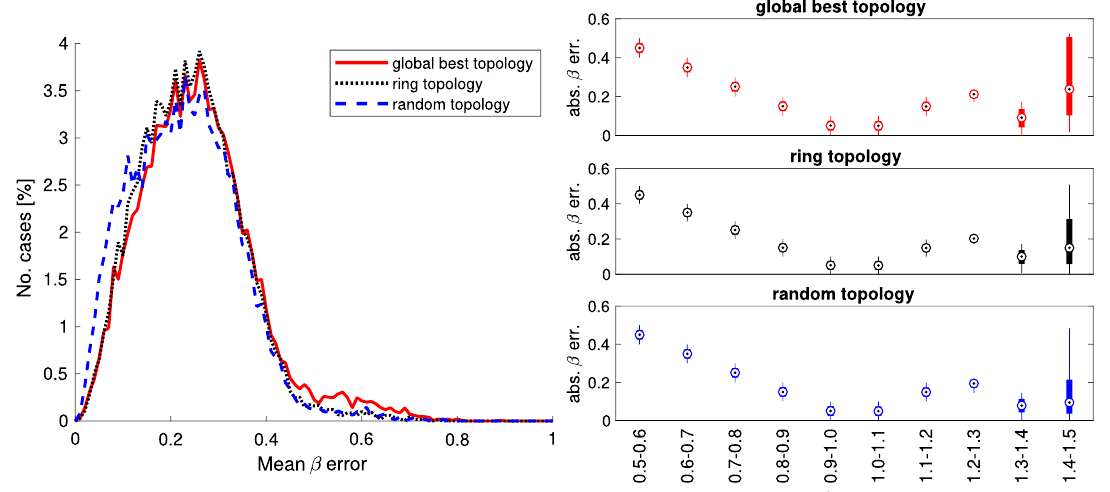
Figure 11. Distributions of mean β errors ( left ) and box-and-whiskers plot of absolute β errors dependent on true β ranges ( right ).